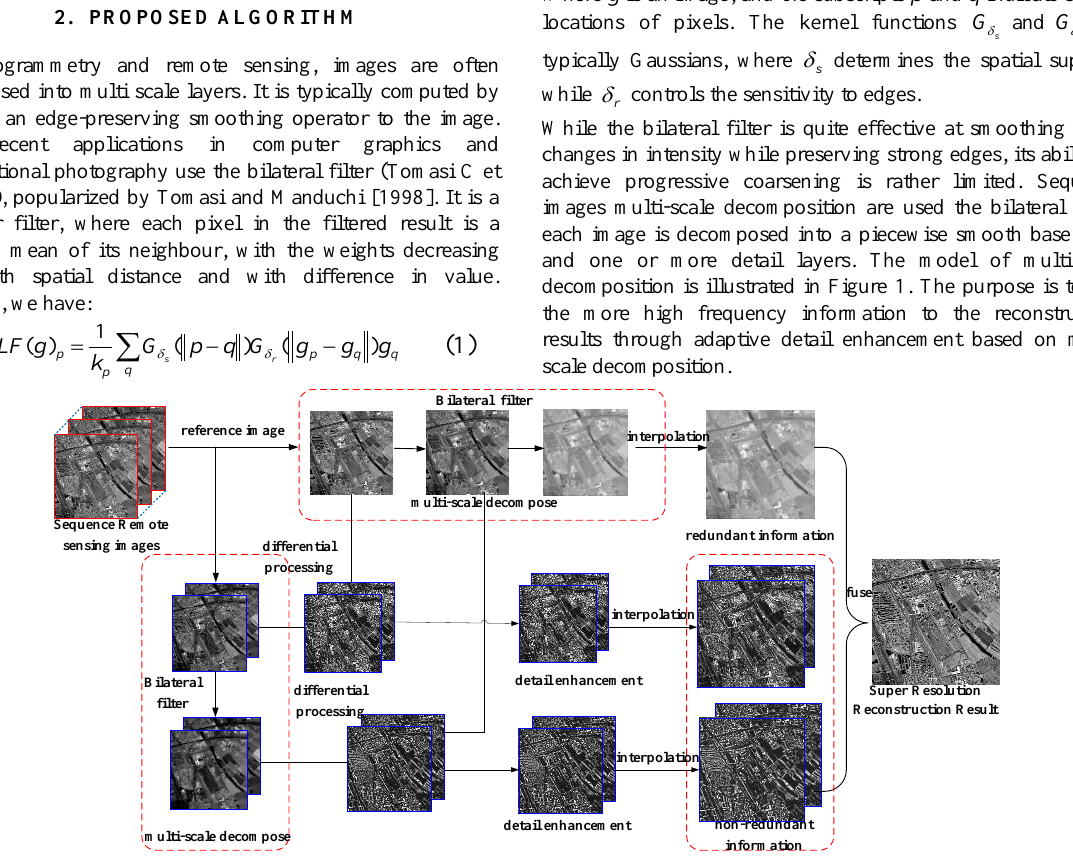
Fig.1 Flow chart of the proposed super resolution